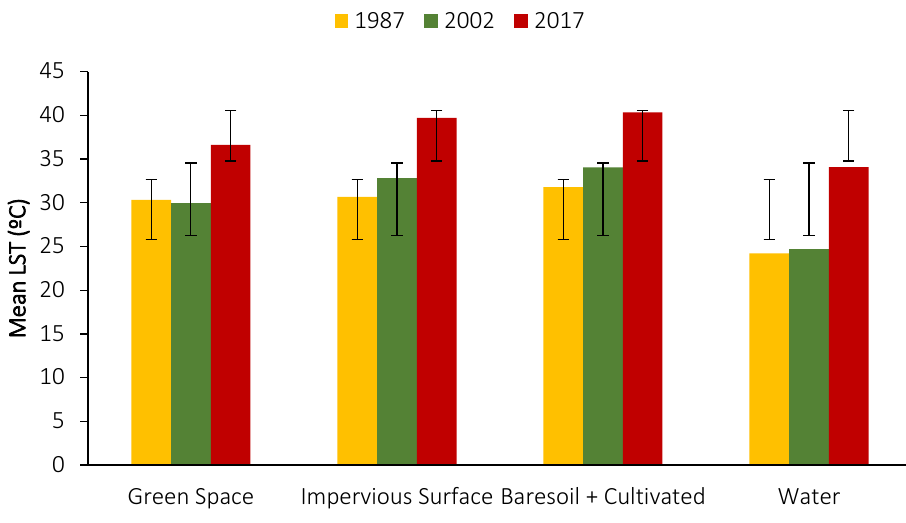
Figure 5. Mean LST of the LULC classes in Seville City (1987, 2002 and 2017).